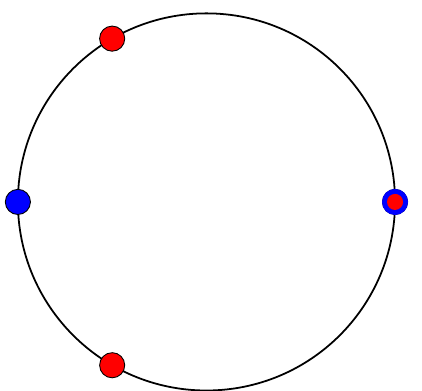
Figure 1 . The IIE pitorically: a given U(1) is broken, by instantons, to a Z N and a Z M discrete symmetries. If N and M are co-prime numbers there is no common subgroup and the U(1) is completely broken. This example illustrates the mechanism for N = 2 and M = 3. It can be easily seen that the blue and red dots only coincide in one point (mod 2 (cid:25)